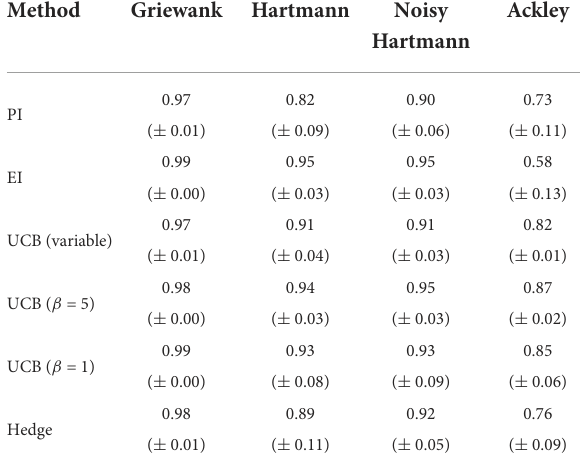
TABLE 3 Averaged area under the curve with standard error for analytical single-point acquisition functions with one initial training point per input dimension.